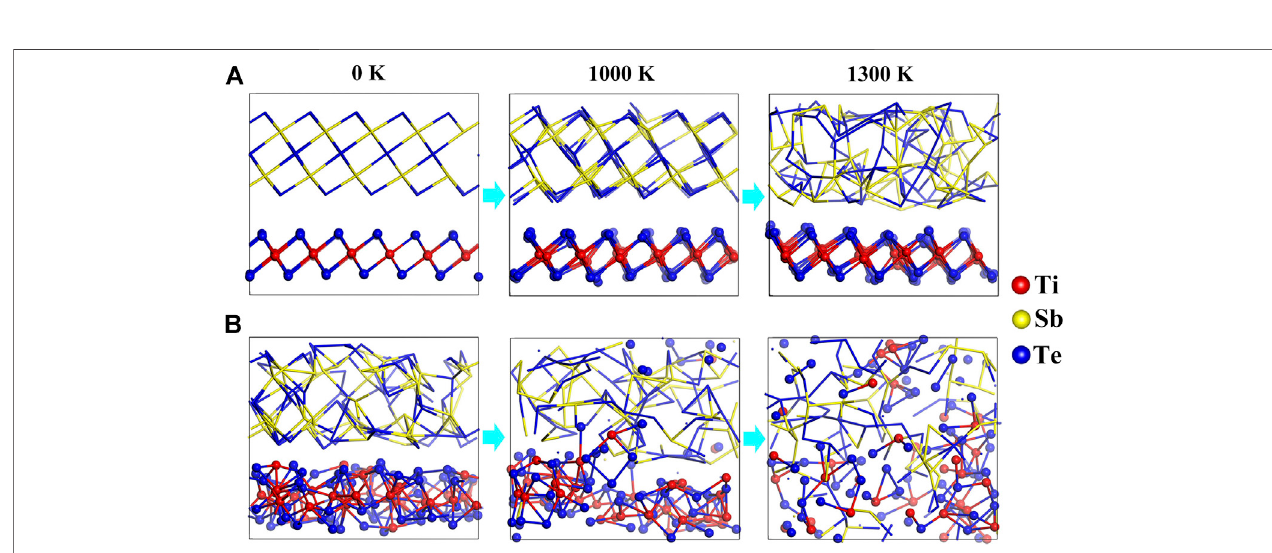
FIGURE 3 | (A) DFMD simulations of the melting process of the PCH model. The PCH model is fi rstly heated up to 1,000 K rapidly within 30 ps. The Sb 2 Te 3 and TiTe 2 sublayers are ordered. The Sb 2 Te 3 sublayer is fully melted at 1,300 K after 30 ps, while the TiTe 2 sublayer remains in the stable crystalline form. (B) DFMD simulations of the melting process of the SLL model. The SLL model contains partially ordered Sb 2 Te 3 and TiTe 2 sublayers. After heating up to 1,000 K for 30 ps, the Sb 2 Te 3 sublayerbecomesfullydisordered and mixes withthe TiTe 2 sublayer.Asthemodel isfurtherheatedat 1,300 Kfor30 ps,the wholemodelbecomesafully disordered liquid phase.